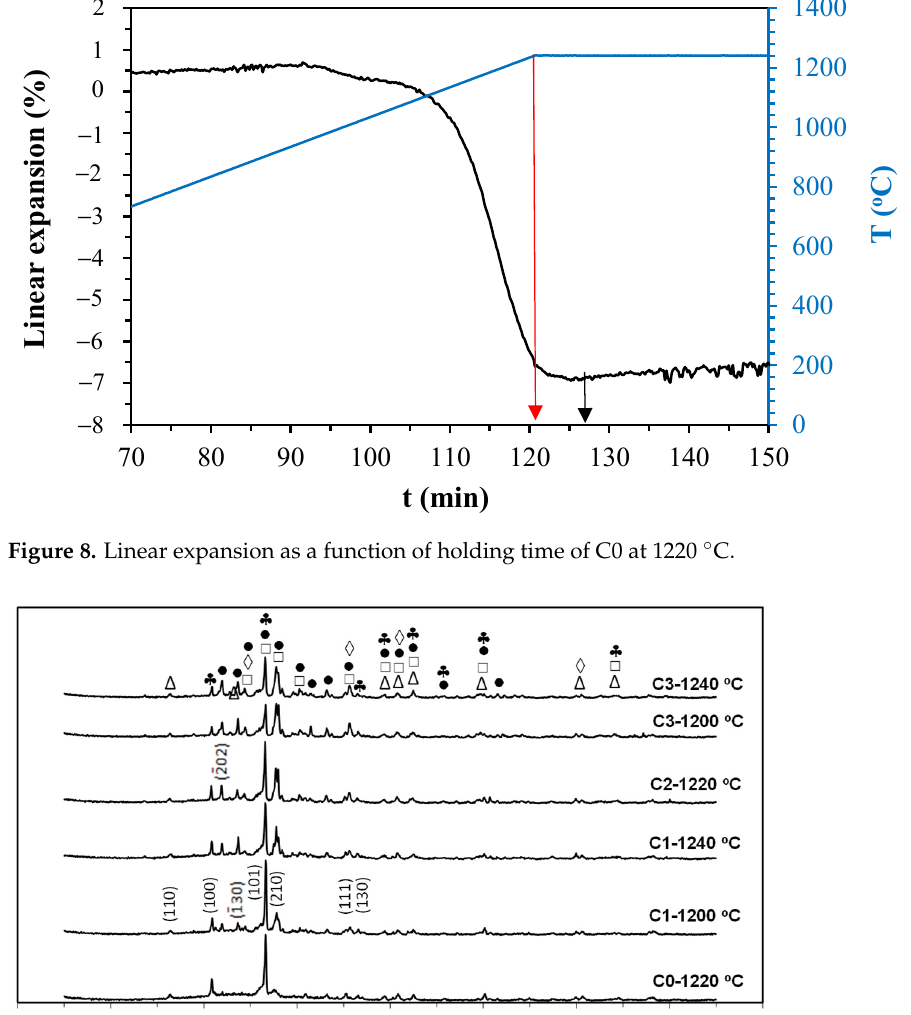
Figure 8. Linear expansion as a function of holding time of C0 at 1220 °C.